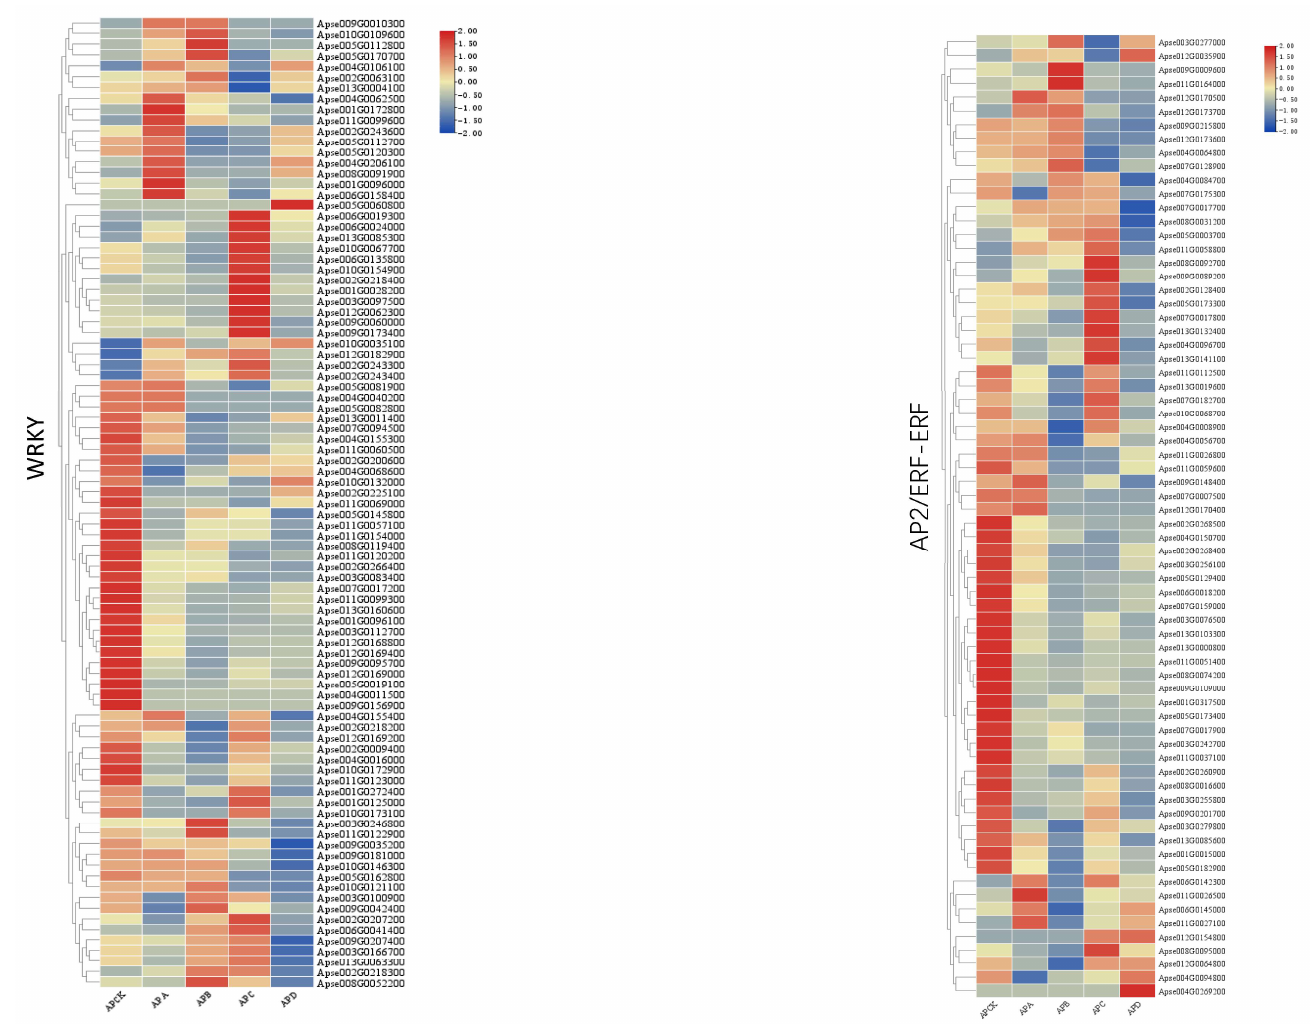
Figure 9. Expression of MYB, AP2/ERF, and WRKY genes. APCK: A. pseudosieboldianum treated at 4 °C; APA: A. pseudosieboldianum treated at −10 °C; APB: A. pseudosieboldianum treated at −20 °C; APC: A. pseudosieboldianum treated at −30 °C; APD: A. pseudosieboldianum treated at −40 °C.